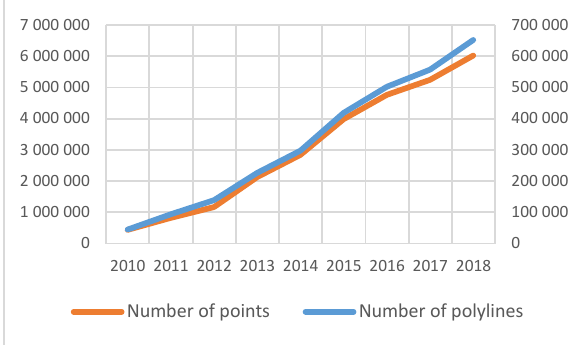
Figure 3. Growth of the road layer The best visualization of the database evolution is the development of the map visualization of the data. Fig. 4 shows the road network density near to Budapest in years 2010, 2015 and 2018 respectively. Notice that first main roads have been mapped, then lower category roads are digitized.